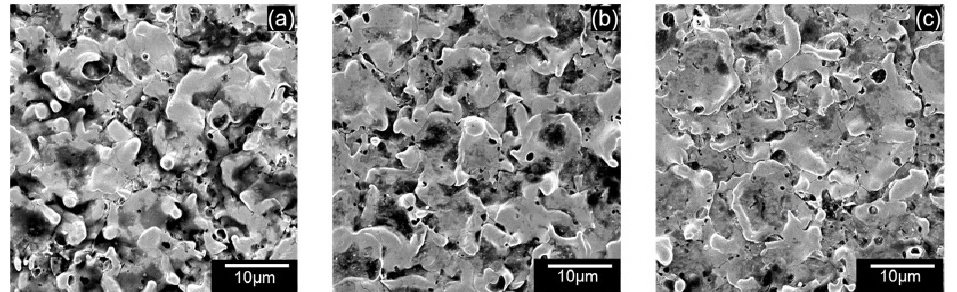
Figure 17. SEM of machined surface using 0.5 g/L alumina at ( a ) 90 V ( b ) 100 V, ( c ) 110 V.